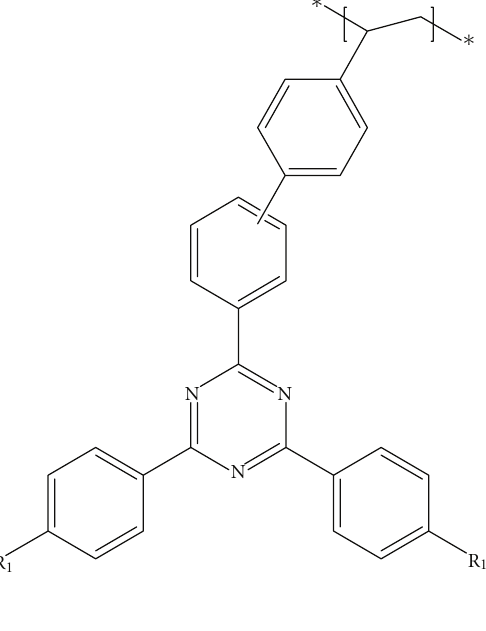
Figure 1: General structure of the electron-transporting poly- styrenes 9a/b–12a/b with 2,4,6-triphenyl-1,3,5-triazine side groups (a: meta; b: